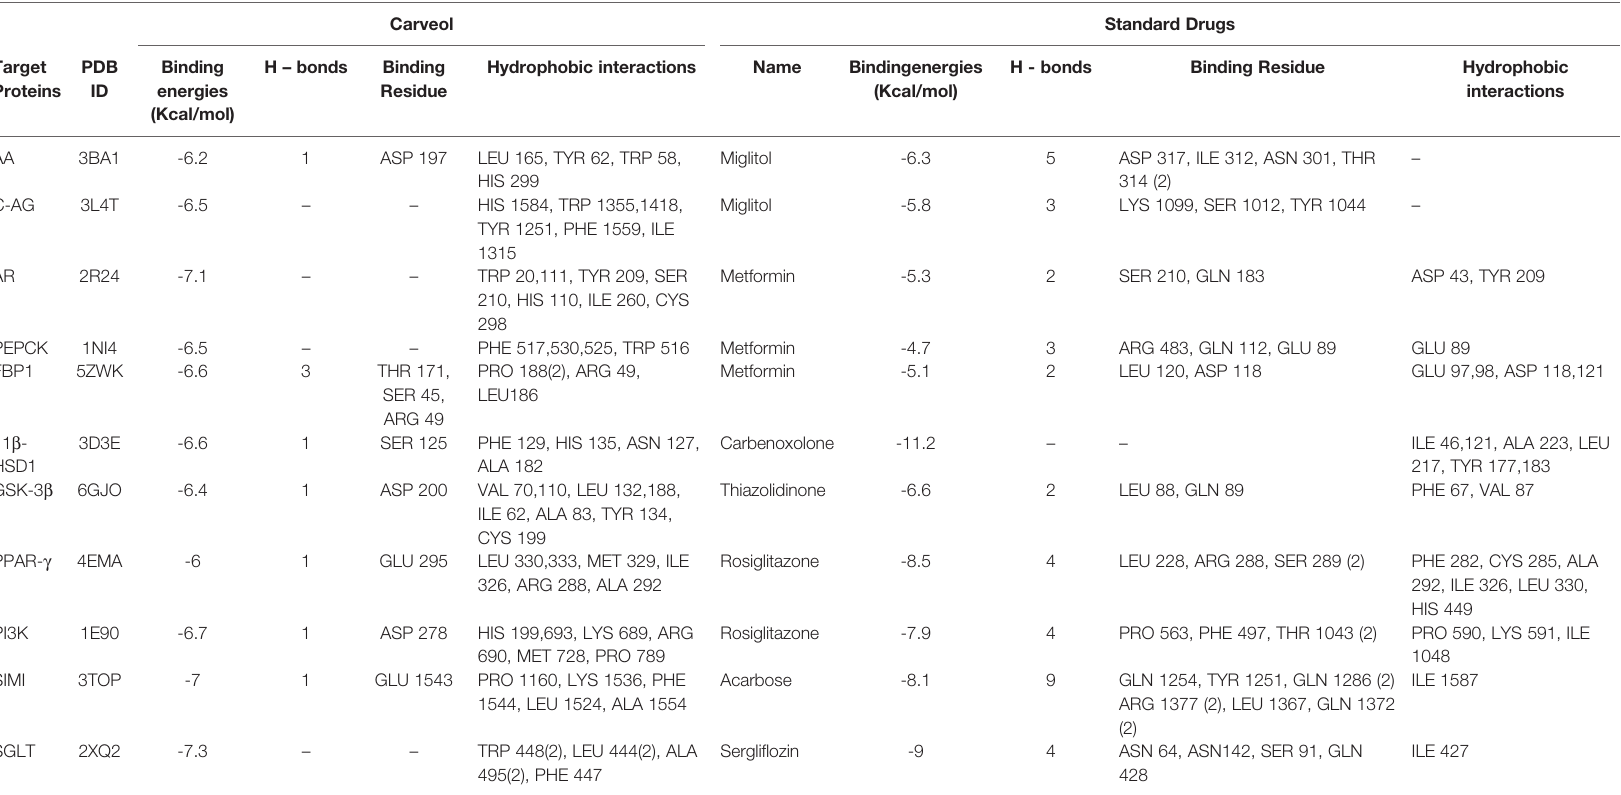
TABLE 1 | Atomic contact energy (ACE) values (Kcal/mol) of best-docked poses of carveol and standard drugs, as well as hydrogen bonds and hydrophobic interactions formed, against AA, alpha-amylase; C-AG, C-alpha Glucosidase; AR, aldose reductase; PEPCK, phosphoenolpyruvate carboxykinase; FBP1, fructose-1,6-bisphosphatase; 11b-HSD1, 11b-hydroxysteroid dehydrogenase-1; GSK-3b, glycogen synthase kinases-3b;